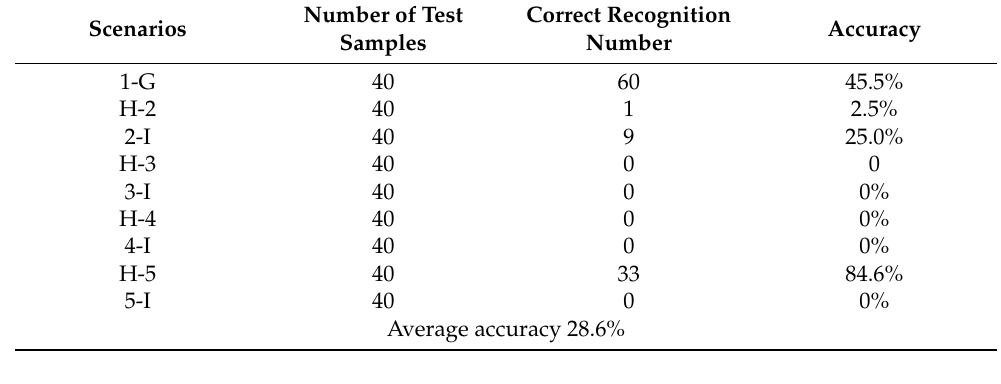
classification accuracies. In Figure 16, the symbols ○ and * stand for the actual and ex- pected labels, respectively. When they overlap, the predicted labels match the actual ones. This model’s recognition accuracy was only 28.6%. Table 11. PNN ‘s accuracy for different scenarios. Table 11. PNN ‘s accuracy for different scenarios.